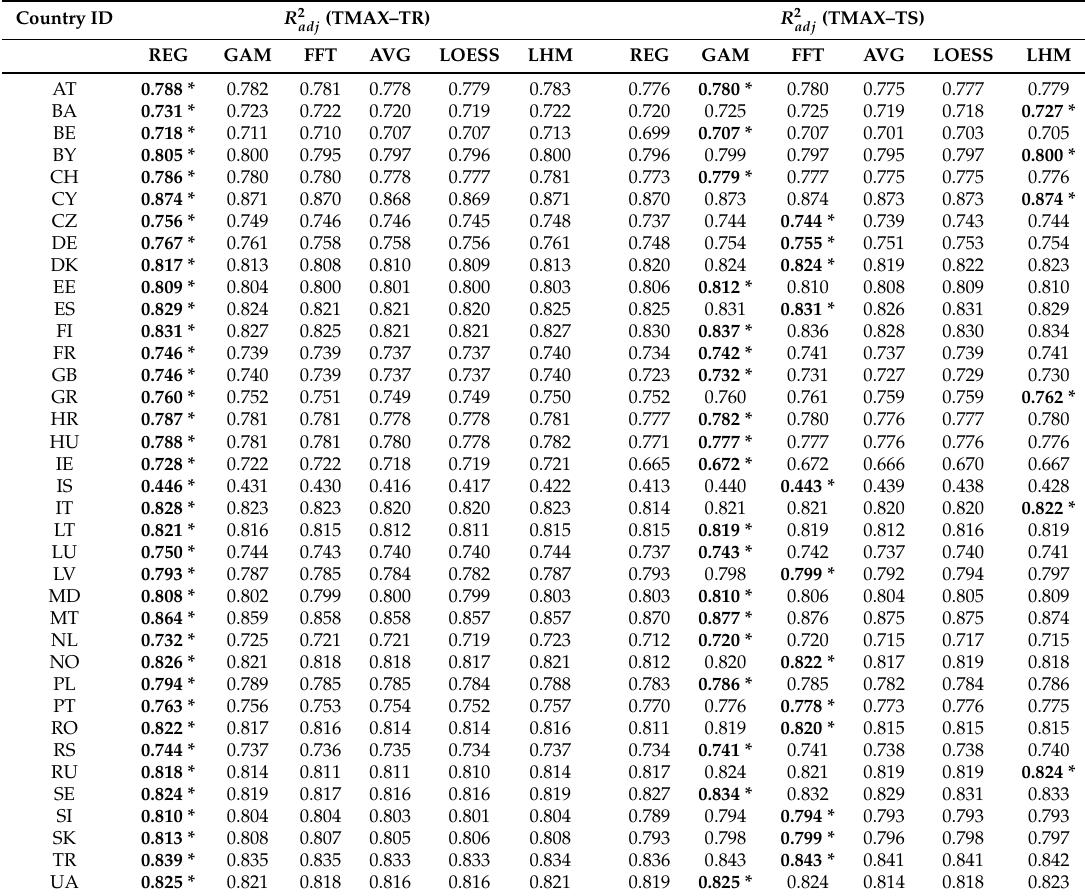
Table 4. Summary of the in-sample (TR) and out-of-sample (TS) Adjusted R-squared ( R 2 maximum temperatures, obtained with all the different methods and for all the countries. The bold values with * indicate the best method for each country and dataset.